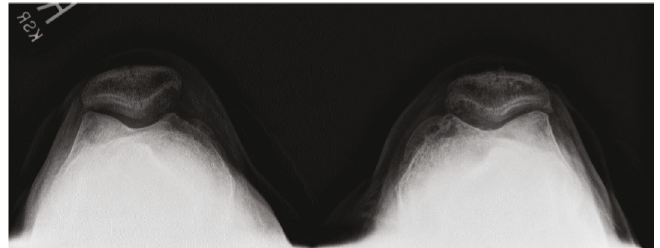
Figure 3: Preop merchant knee X-ray.